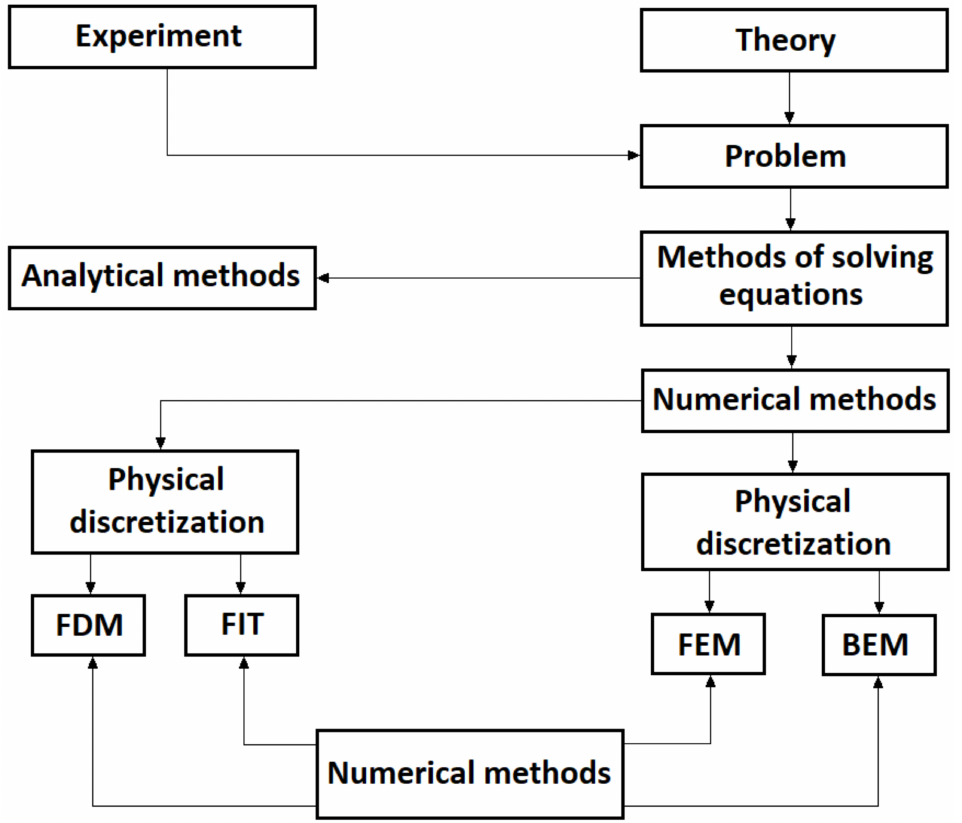
Figure 7. Schematic diagram showing the execution of numerical